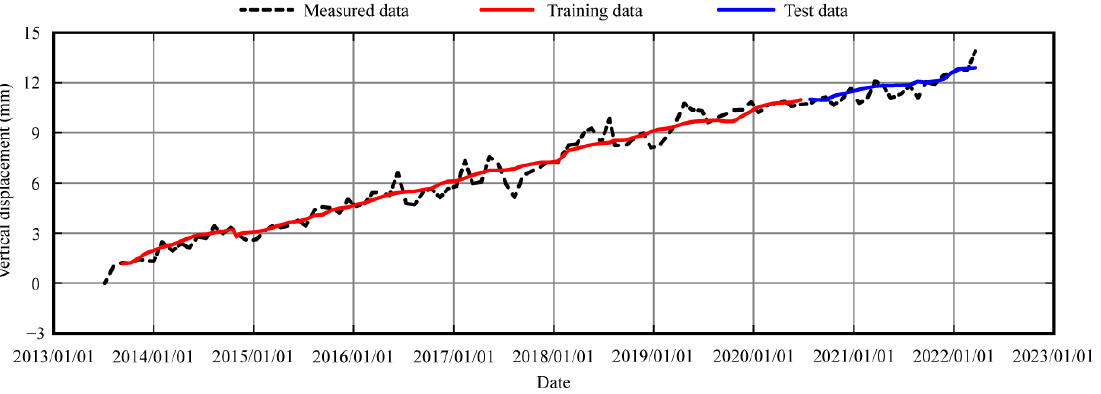
Figure 3. Process lines of settlement for measuring point LD12ZT01 (LSTM model).